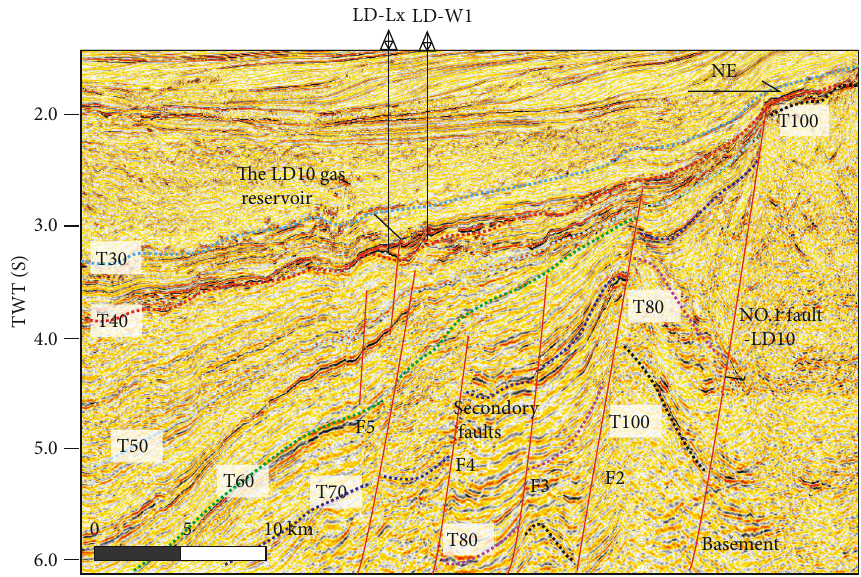
Figure 8: The SE-oriented seismic section (L2) of the LD10 gas reservoir reveals that the No. 1 fault has a forward fault-step structure near the LD10 gas fi eld. The many secondary faults in the hanging wall, which are oriented parallel to the main fault, extend into the basement. The section location is shown in Figure 1. Our 3D seismic data extend as deep as 7S.